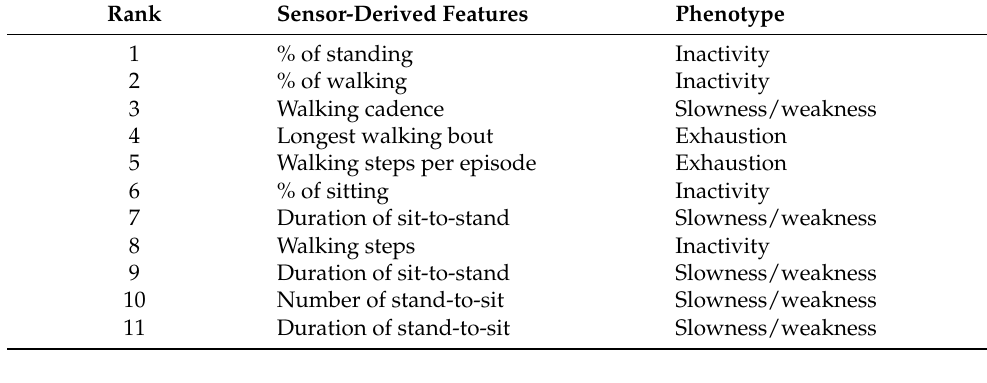
Table 5. Ranking of 11 sensor-driven features identified from machine learning.